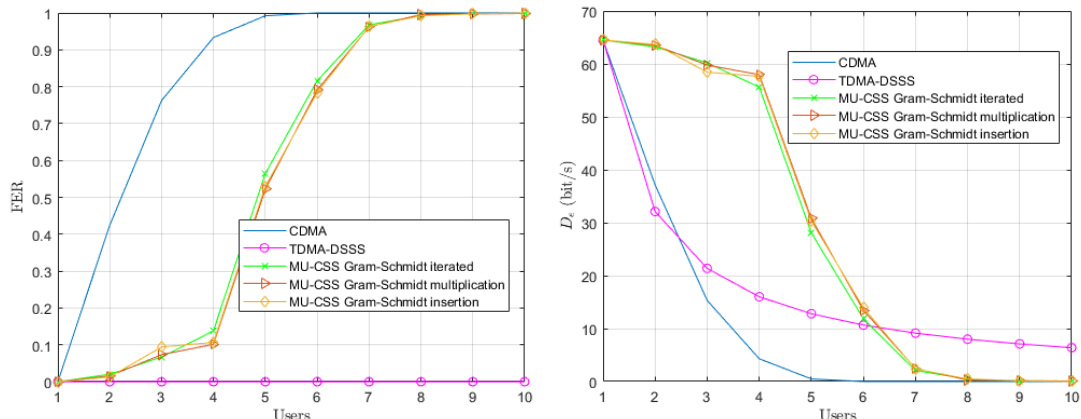
Figure 8. Average FER performance ( left ) and effective date rate ( right ) versus number of users over the time-varying UWA channel model with mobile users.